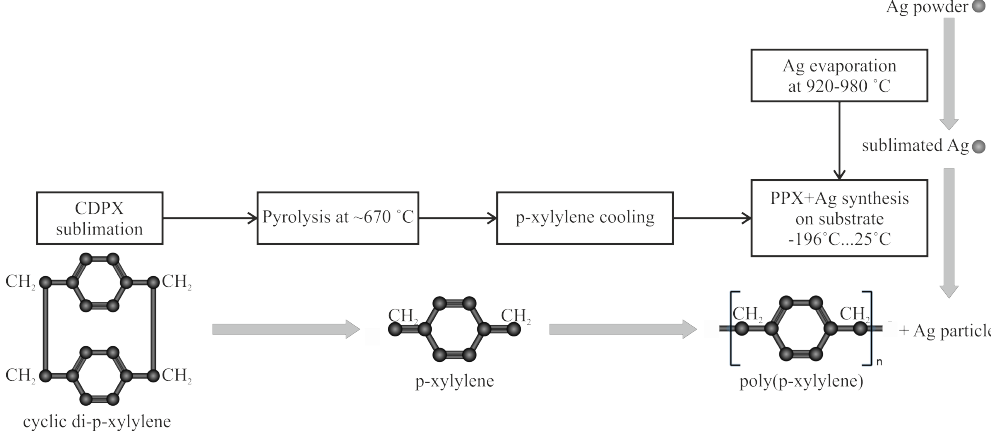
Figure 1. The scheme of poly(p-xylylene) (PPX)+Ag coating